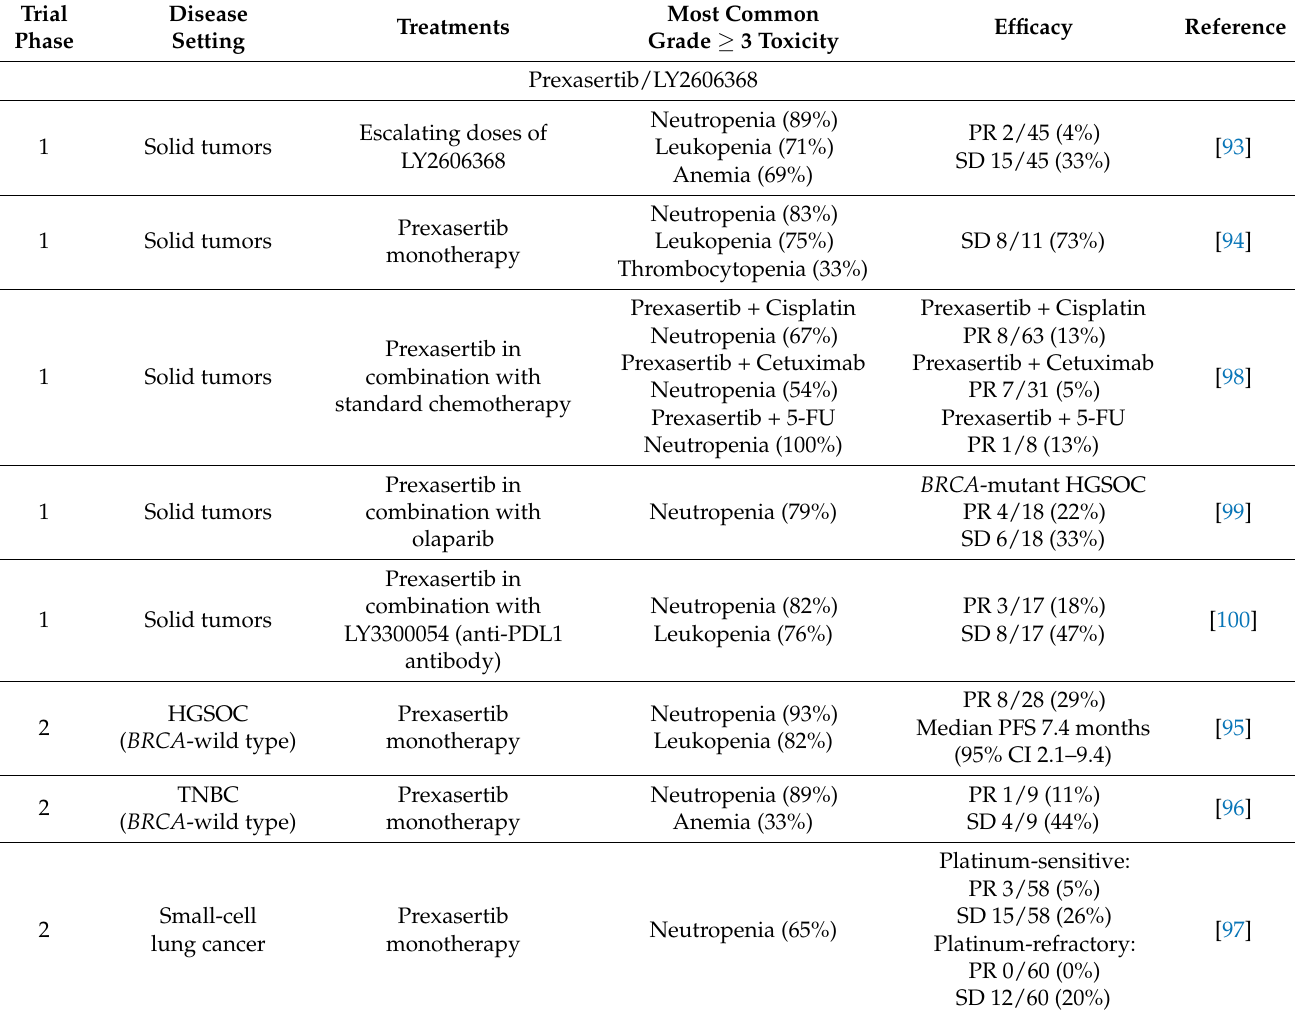
Table 3. Clinical trials of CHK1/2